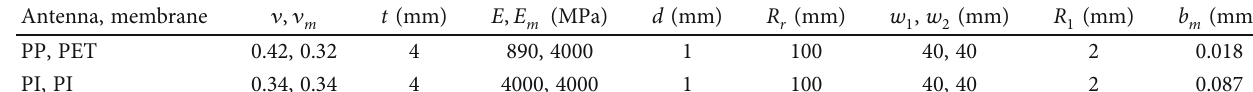
Table 1: Parameters of membrane and conical spiral